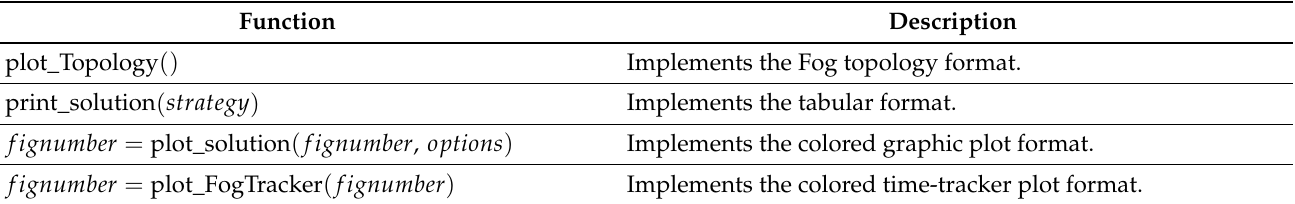
Table 5. Rendering functions for the supported formats implemented in DeepFogSim . Function Description plot_Topology () Implements the Fog topology format. print_solution ( strategy ) Implements the tabular format. fignumber = plot_solution ( fignumber , options ) Implements the colored graphic plot